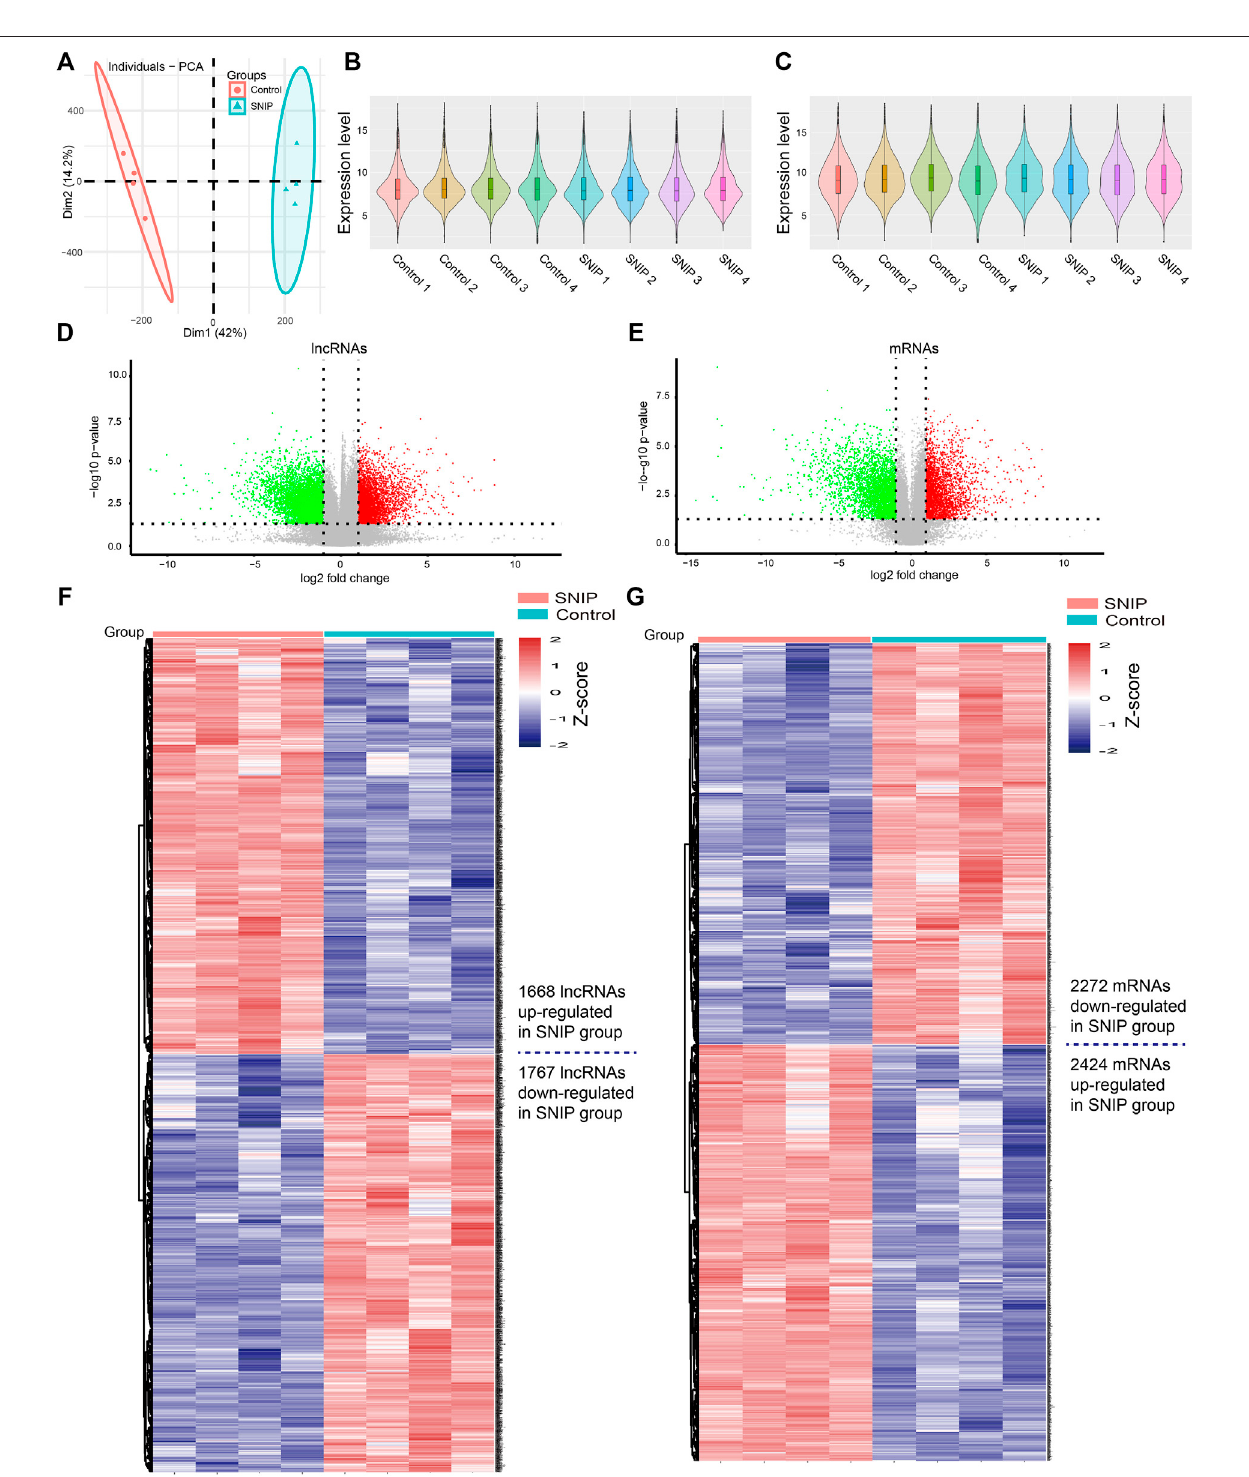
FIGURE 1 | Alterations in lncRNA and mRNA expression pro fi les between SNIP tissues and nontumorous tissues (A) Principal component analysis (PCA) (B-C) The violin plot is a convenient way to quickly visualize the distributions of a dataset of lncRNA (B) and mRNA (C) pro fi les (D – E) The volcano plots show differentially expressed lncRNAs (D) and mRNAs (E) in the SNIP tissuesrelative tothose from the Controlgroup. The horizontal linerepresentsa p value of0.05 and the vertical lines correspond to 2.0-fold up and down (F – G) The heat maps indicate hierarchical clustering results of differentially expressed lncRNAs (F) and mRNAs (G) (fold change > 2; p < 0.05). Each row indicates one lncRNA or mRNA, and each column indicates one sample. The lncRNA and mRNA expression levels are illustrated using histograms and Z-scores. The red and blue bars denote high and low relative expression, respectively.